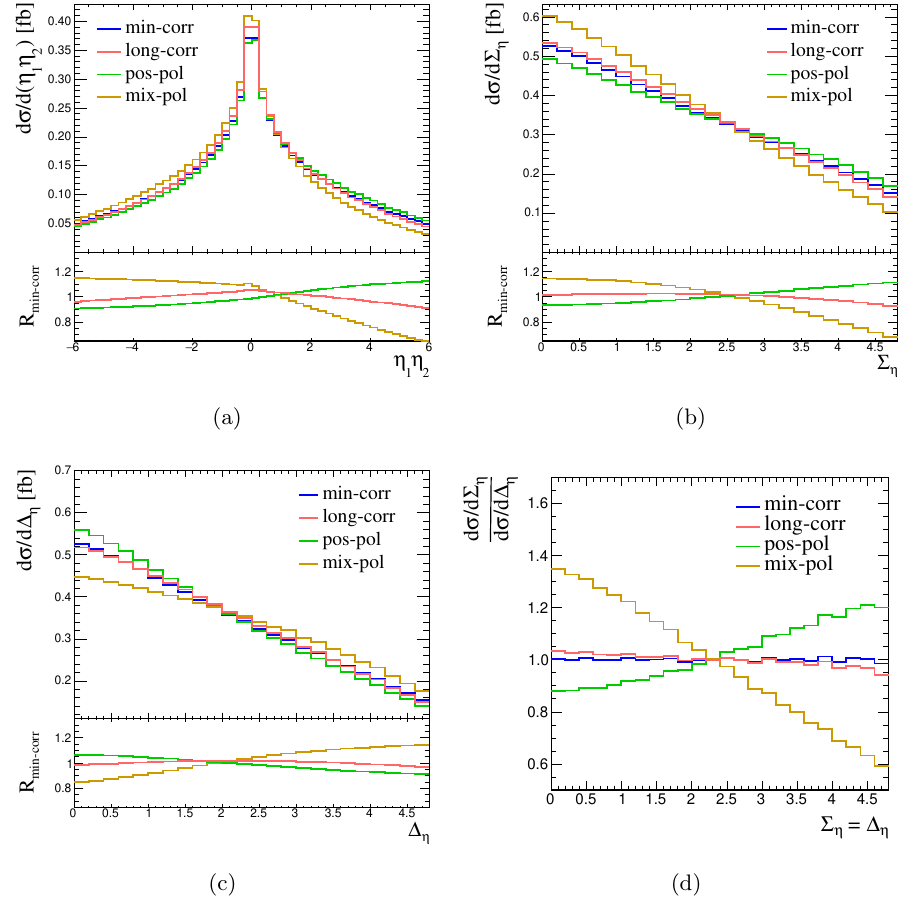
Figure 3 . Upper panels: distributions of the muon rapidity sum (cid:6) (cid:17) (top left) and di(cid:11)erence (cid:1) (cid:17) (top right) for the di(cid:11)erent models. Lower panels: distribution of the ratio between the sum and di(cid:11)erence of rapidities versus the values of (cid:6) (cid:17) and (cid:1) (cid:17) respectively in the relevant ranges (bottom left) and the product of the muon rapidity for the di(cid:11)erent models (bottom right). The ratio R min-corr shows the comparison of di(cid:11)erent models to the min-corr scenario.